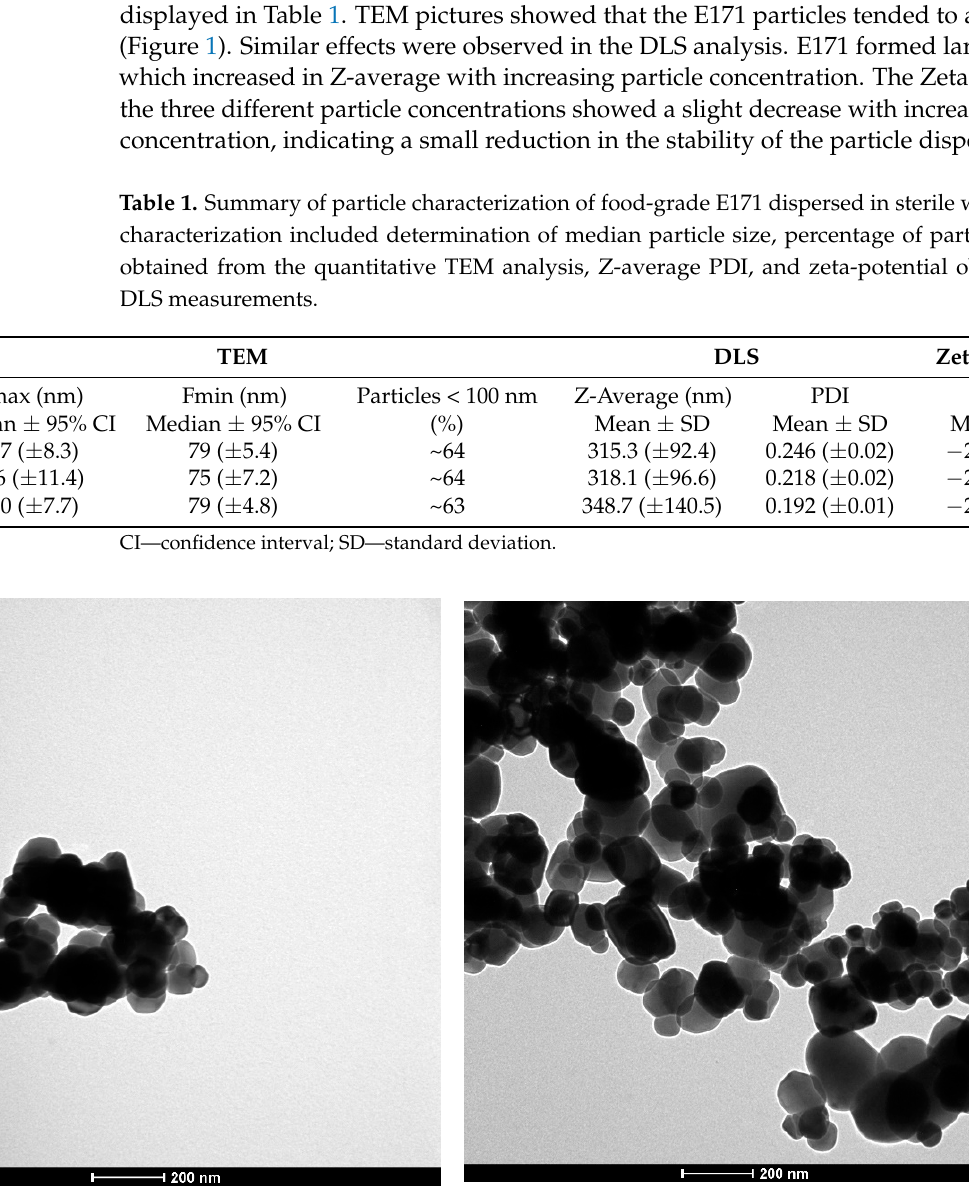
Table 1. Summary of particle characterization of food-grade E171 dispersed in sterile water. Particle characterization included determination of median particle size, percentage of particle >100 nm obtained from the quantitative TEM analysis, Z-average PDI, and zeta-potential obtained from DLS measurements.